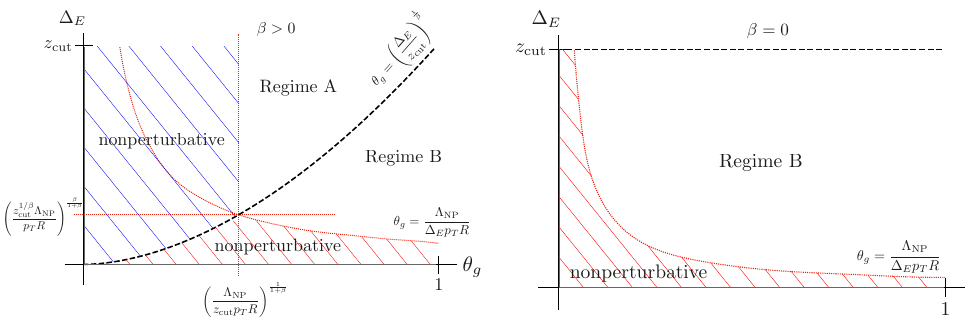
Figure 14 . The nonperturbative regions for soft drop with β > 0 (left) and β = 0 (right). Plots are not to scale to highlight the nonpertubative